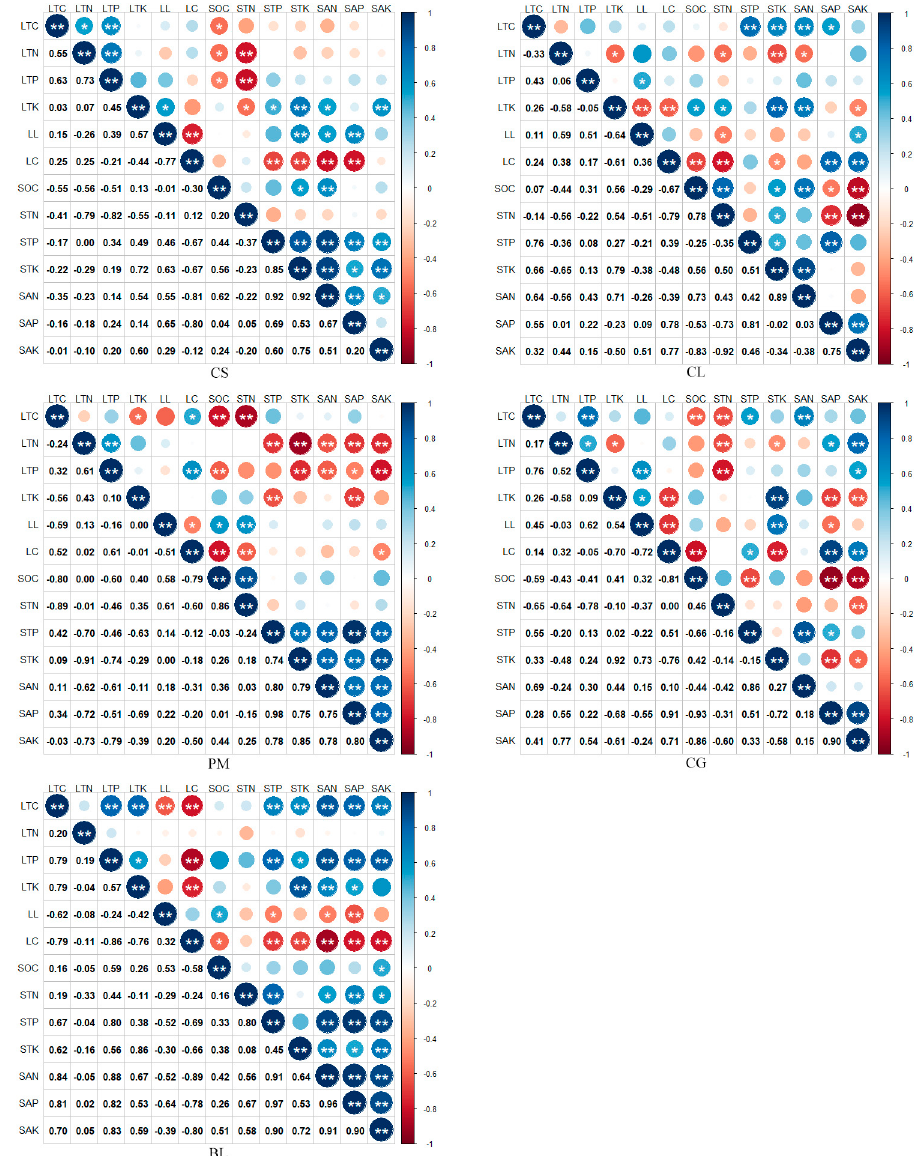
Figure 10. Correlation between the nutrient release rates of litter and soil nutrient contents. CS—